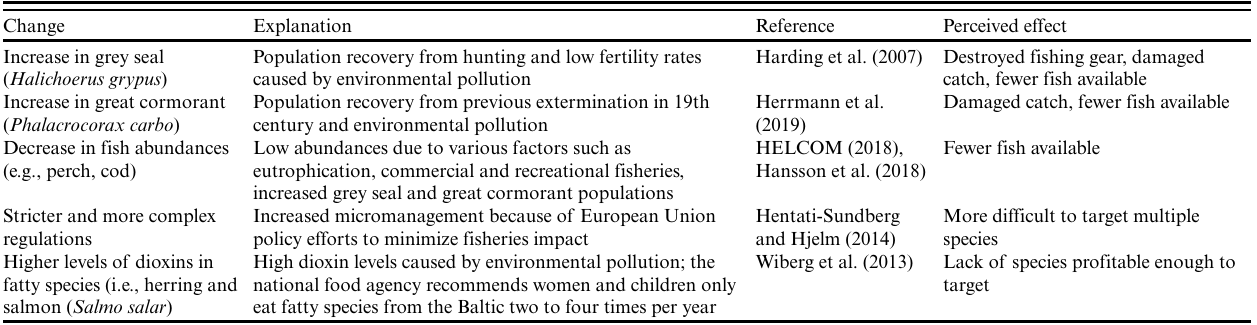
Table 2 Description of social and ecological changes identified by fishers as affecting their fishing livelihood and leading to reduced fishing opportunities between 1990 and 2016.